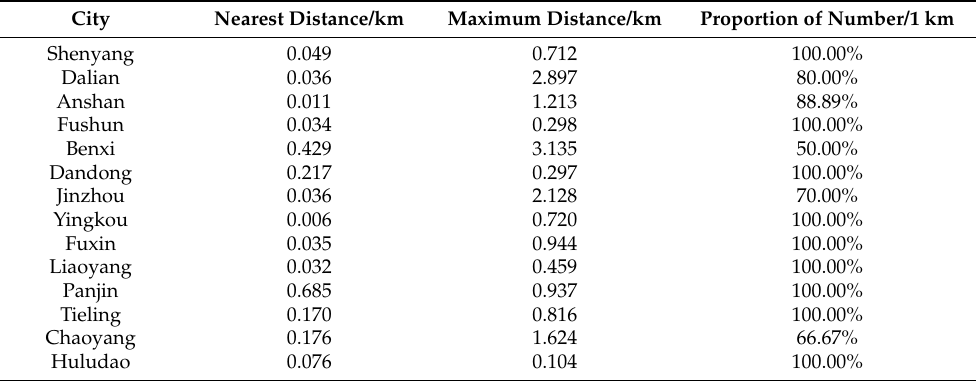
Table 8. Statistical Table of Distance between Warehouse Supermarkets and Municipal Government in Liaoning